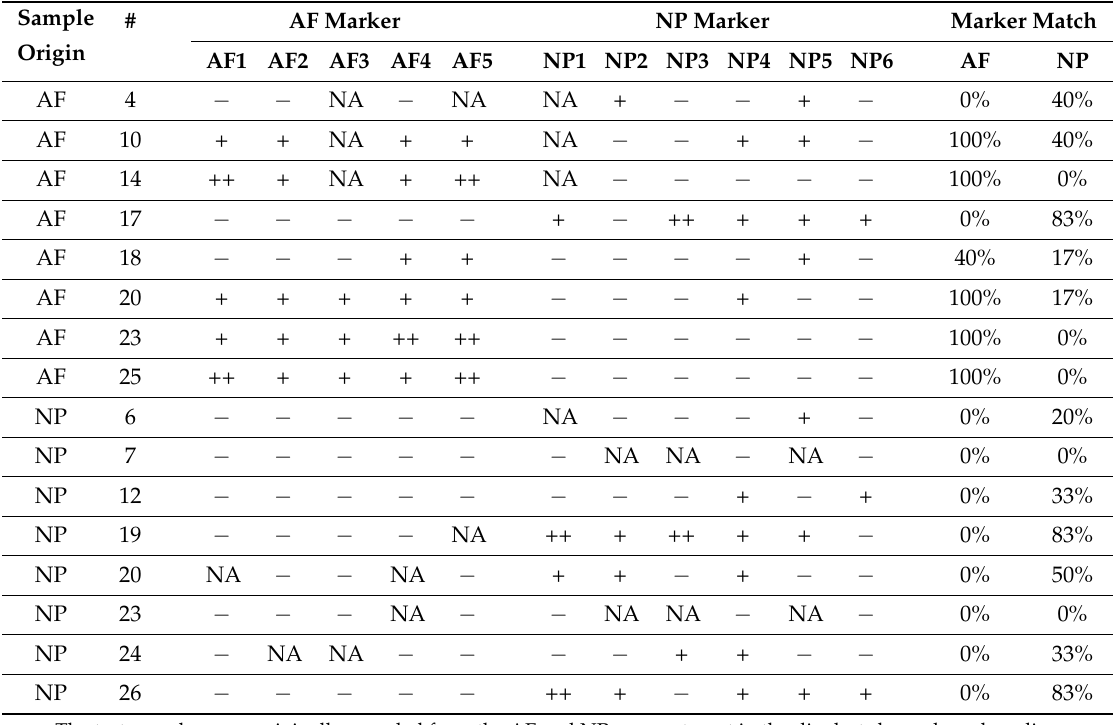
Table 5. AF and NP marker expression profile in unknown test